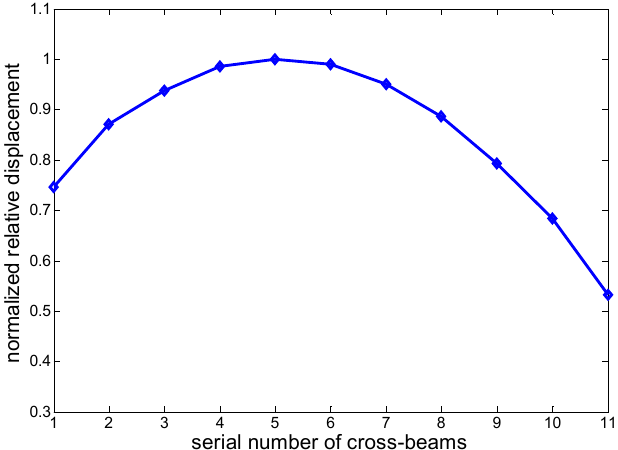
Figure 10. Normalized relative displacements of all the cross-beams.